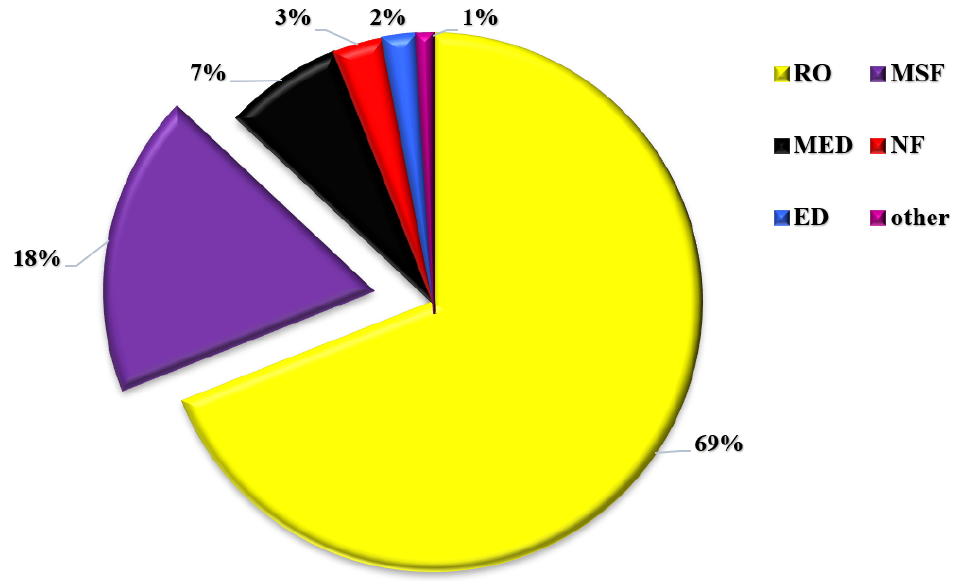
Figure 1. Share of different desalination facilities by technology [5] .